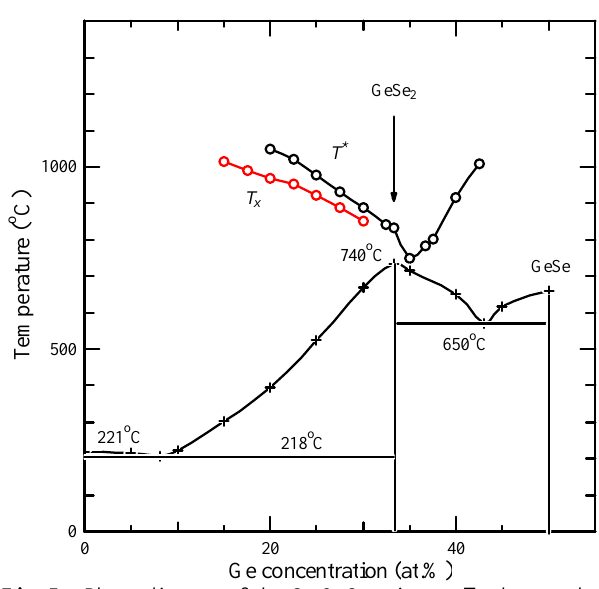
Fig. 5. Phase diagram of the Se-GeSe mixture. T * denotes the position of a minimum in the sound velocity and T x the position of step-wise